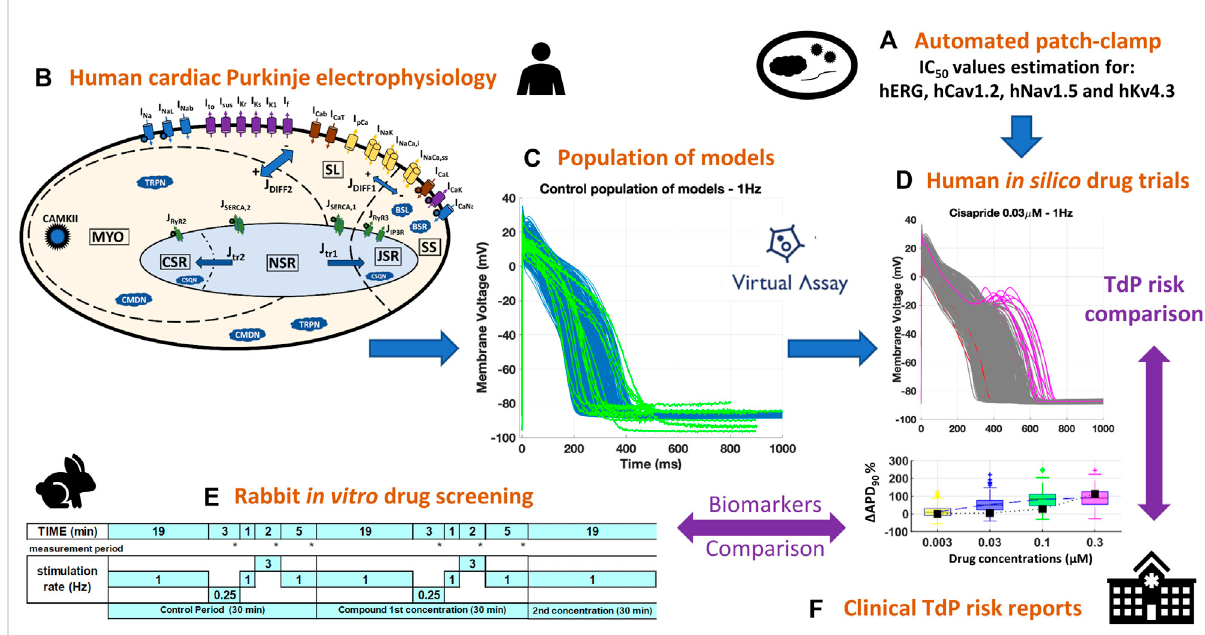
FIGURE 1 Combined experimental-computational pipeline used to perform this study. (A) : In vitro estimation of IC50s through automated patch clamp. (B) : Structure of the biophysically detailed computational model used to simulate human cardiac Purkinje electrophysiology (Trovato et al., 2020a). (C) : Experimentally-calibrated population of 530 models generated using the Virtual Assay software (Oxford University Innovation © 2018); blue traces: computational models; green traces: experimental AP recordings from human healthy cardiac Purkinje cell (Nagy et al., 2015). (D) : Representative example of human in silico drug trials on the population of models, including AP traces (with drug-induced repolarization abnormalities highlighted in pink) and biomarker boxplots. (E) : In silico results were compared against pre-existing in vitro recordings from rabbit Purkinje fi bers,obtainedwiththeprotocoldepictedformultiplefrequenciesandconcentrations. (F) :Both invitro and insilico resultswerecompared against the clinical TdP risk from the CredibleMeds ® repository (Woosley and Romer,